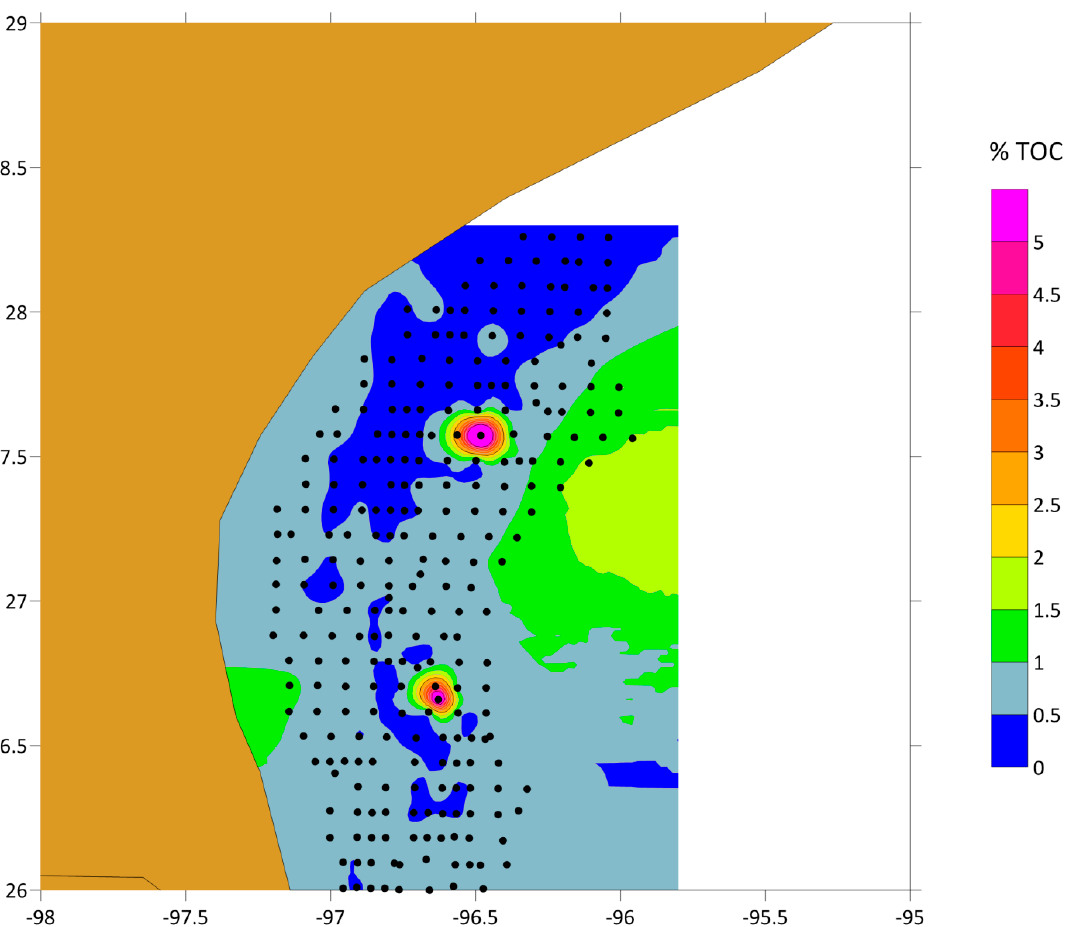
Figure 4. Interpolated sediment TOC concentrations off the Texas coast.